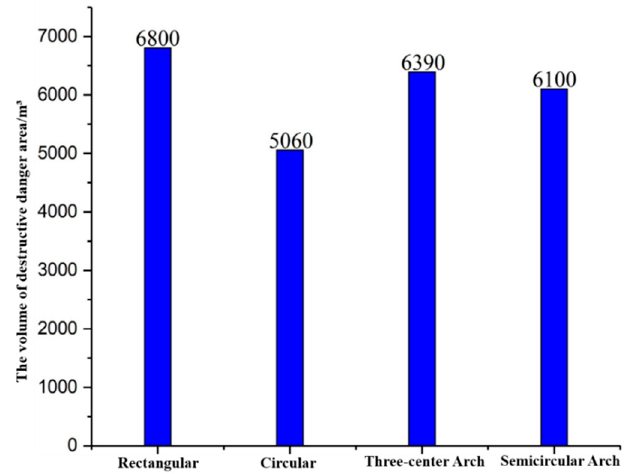
Figure 10. Influence of section shape on the scope of the destructive danger area of the rock surrounding a bottom drainage roadway.